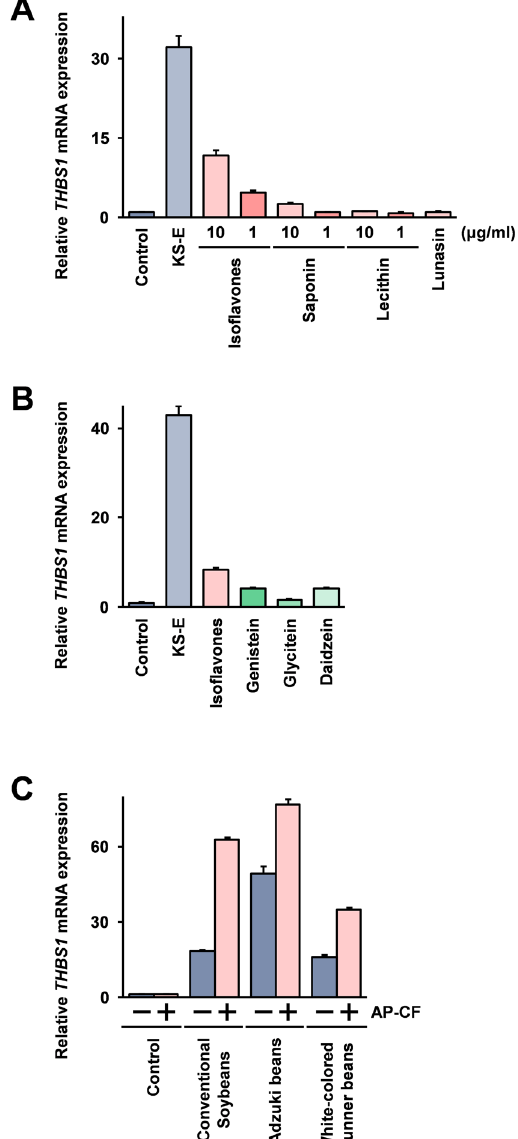
Figure 3. Soy isoflavones are involved in the induction of THBS1. ( A ) Mono Mac 6 cells were stimulated with a 20-fold dilution of KS-E, 20 μ M Lunasin, or isoflavone mixture, saponin, and lecithin isolated from soybeans at the 1 or 10 μ g/ml concentrations indicated in the Figure. ( B ) Mono Mac 6 cells were stimulated with a 20- fold dilution of KS-E, or 10 μ g/ml isoflavone mixture of genistein, glycitein, and daidzein. All compounds are dissolved in 1 μ l dimethyl sulfoxide (DMSO), and all cells including negative and positive (stimulation with KS-E) control cells were treated with 1 μ l DMSO. ( C ) Mono Mac 6 cells were stimulated with hot water extracts prepared from whole beans as indicated in the Figure at 20-fold dilution, with or without AP-CF at the concentration of 100 μ g/ml β -glucan. After 2 hours, the cells were harvested, and the THBS1 mRNA expressions were monitored using the real-time RT-PCR method. The data are represented as relative values compared with the mRNA expression in unstimulated control cells after normalization with GAPDH mRNA expression. Error bars indicate standard deviations calculated by three independent